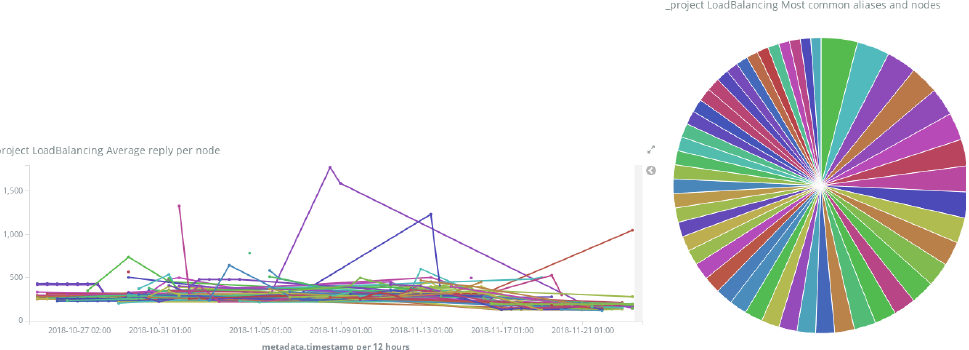
Figure 3: Monitoring of the nodes behind a particular